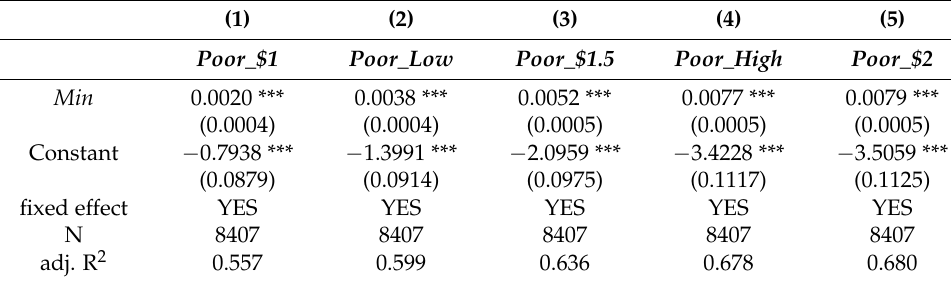
Table 5. Impact of extreme low temperatures on poverty vulnerability.